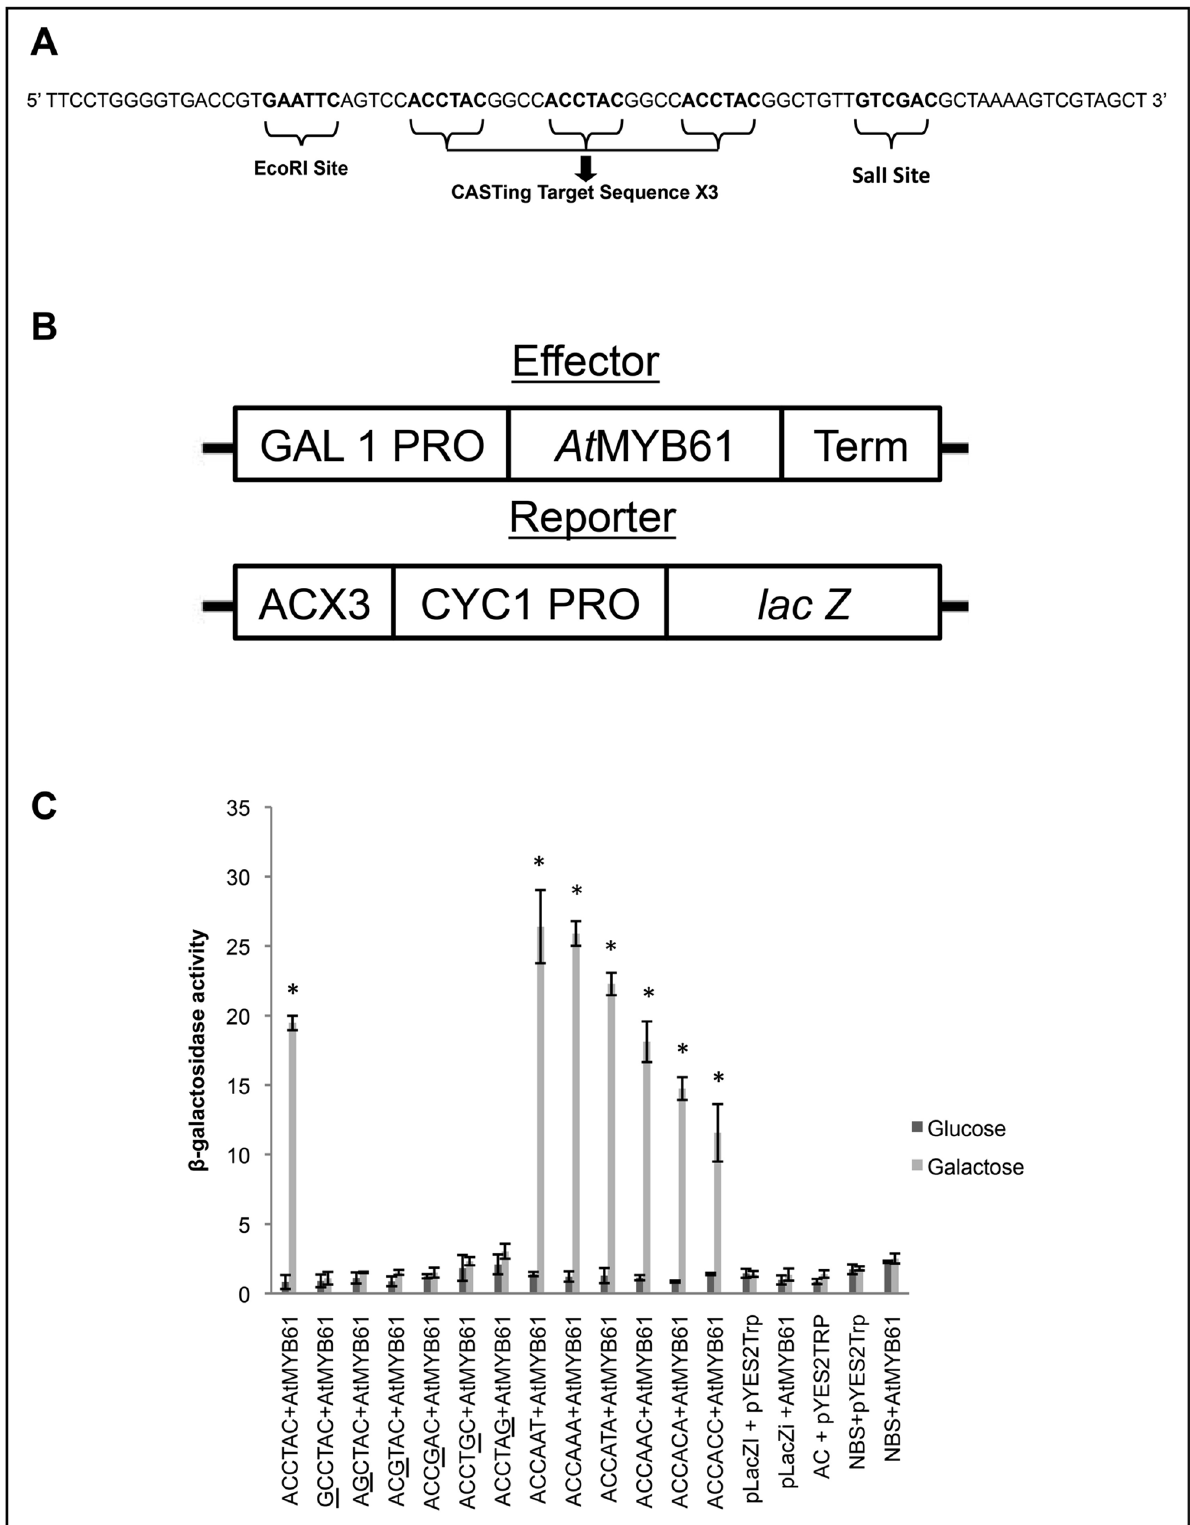
Figure 4. AtMYB61-mediated activation of promoter activity in Saccharomyces cerevisiae in an AC dependent fashion. (A) The sequence of the oligonucleotides cloned into the reporter vector using EcoRI and SalI sites. Each AC element or mutated ACI element is triplicated within the segment. (B) Schematic representations of the Effector (pYES2TRP::AtMYB61) and Reporter (pLacZi::AC) constructs used in this assay (CYC1: minimal yeast promoter). (C) Quantitative analysis of b -galactosidase activity in yeast after induction. The measurements in liquid assay were made from three biological independent replicates. Activation of artificial genes comprising a minimal CYC1 promoter fused to a tandem AC element or